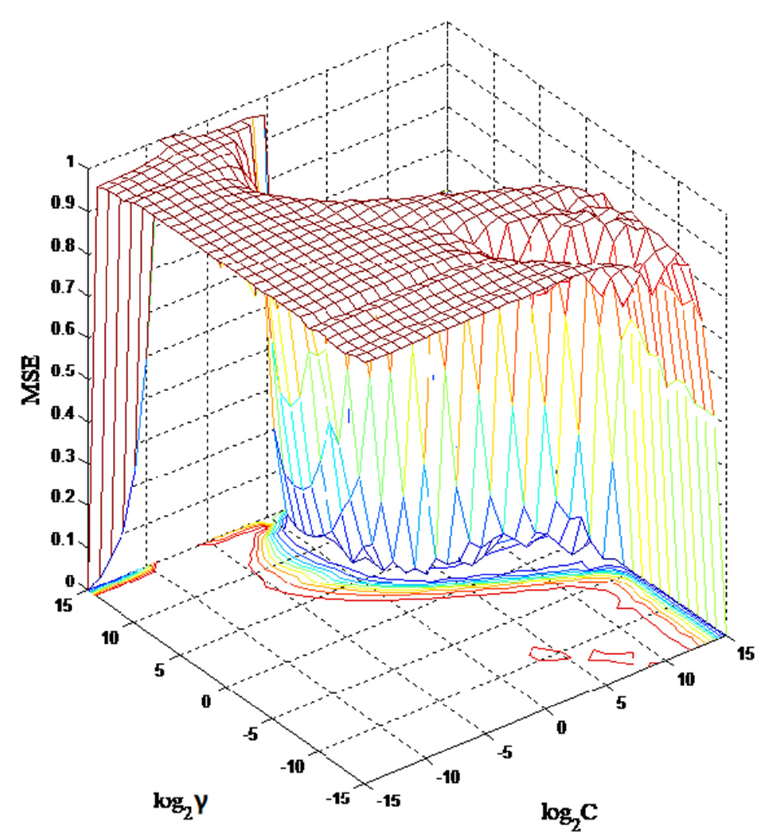
Figure 10. Parameter optimization of SVM regression model.